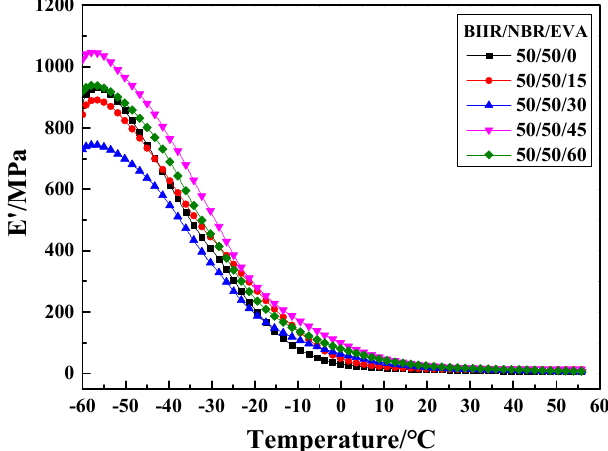
Figure 15. Storage modulus E ′ versus temperature of NBR/BIIR/EVA with various blend ratios.